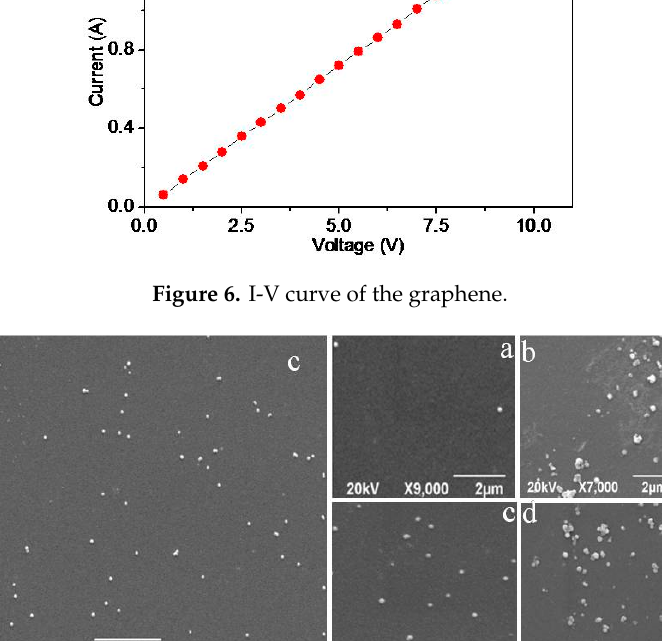
Figure 6. I-V curve of the graphene.